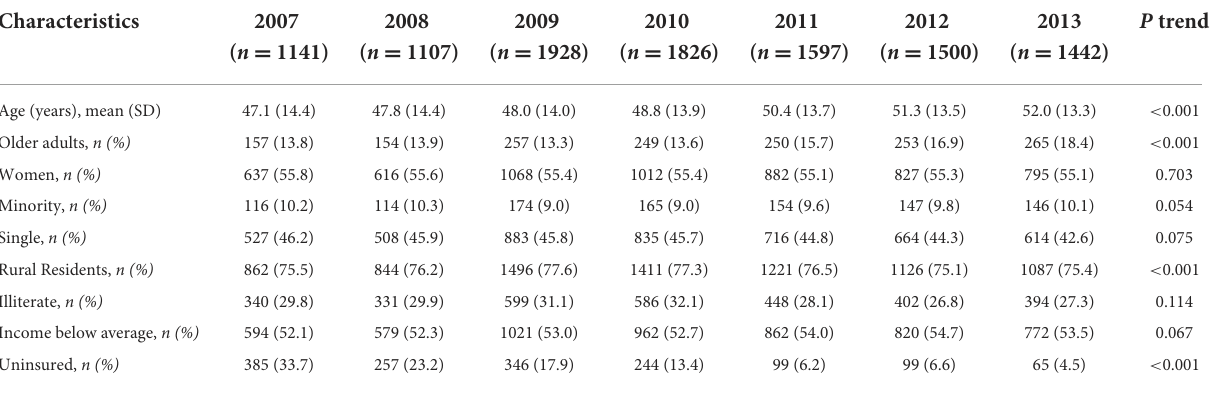
TABLE 1 Characteristics of participants in the surveys, 2007–2013.